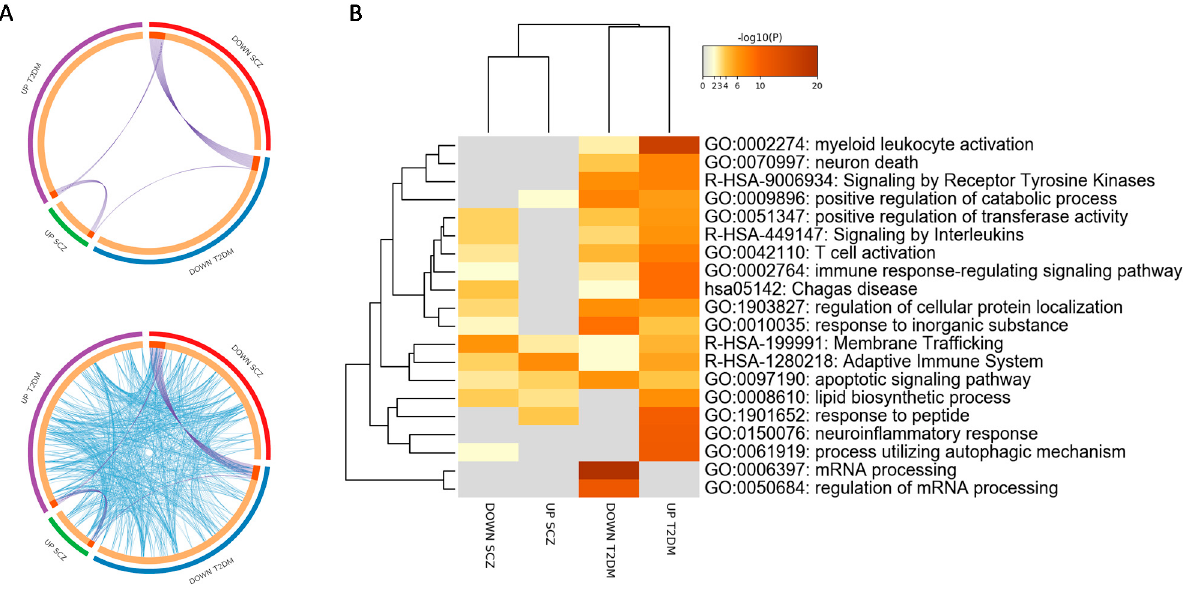
Figure 3. Functional annotations performed on the differentially expressed genes in schizophrenia (SCZ) and type 2 dia- betes mellitus (T2DM) peripheral blood mononuclear cells (PBMCs). ( A ) Circos plot showing overlapping between the differentially expressed genes (DEGs) in SCZ and T2DM PBMCs. Purple lines link the same genes that are shared by the input lists. Blue lines link the different genes that fall in the same ontology term. ( B ) Hierarchical clustering of the top 20 most enriched terms among the DEGs in SCZ and T2DM PBMCs. The heatmap is colored by the p -values, and gray cells indicate the lack of significant enrichment.